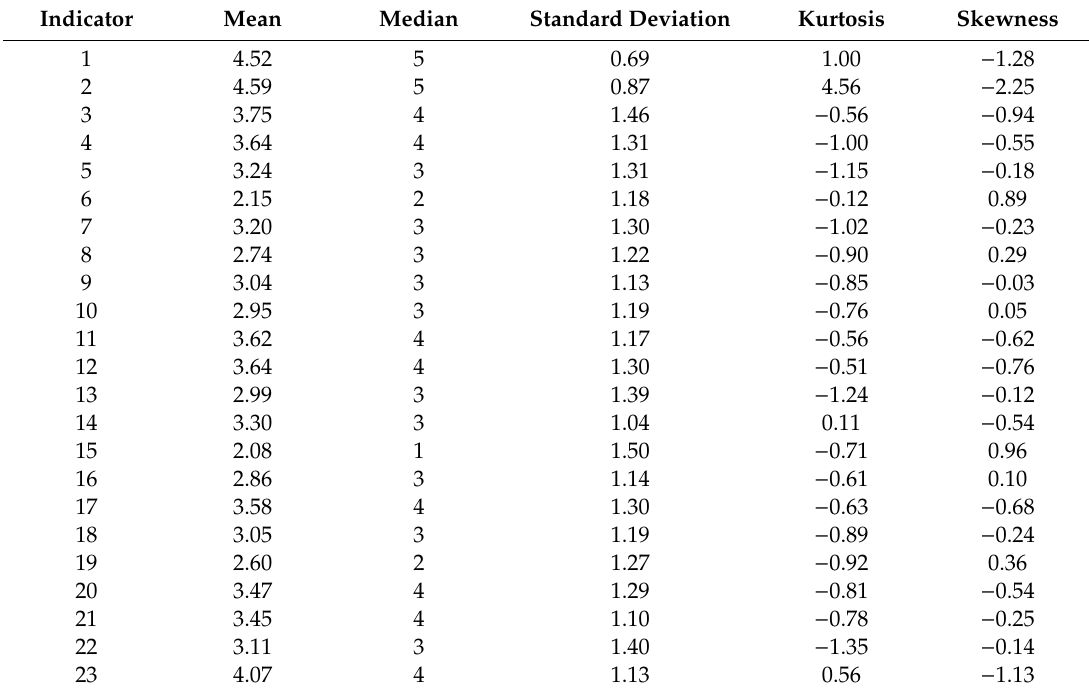
Table 4. Basic descriptive statistics of each